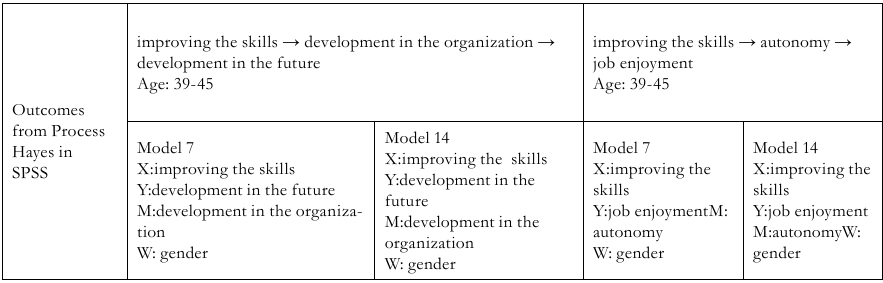
Tab. 2 – The significance of gender as a moderator, found only for employees of age 39-45. Source: Own calculation on a base of the models 7 and 14 in the Process Hayes in SPSS